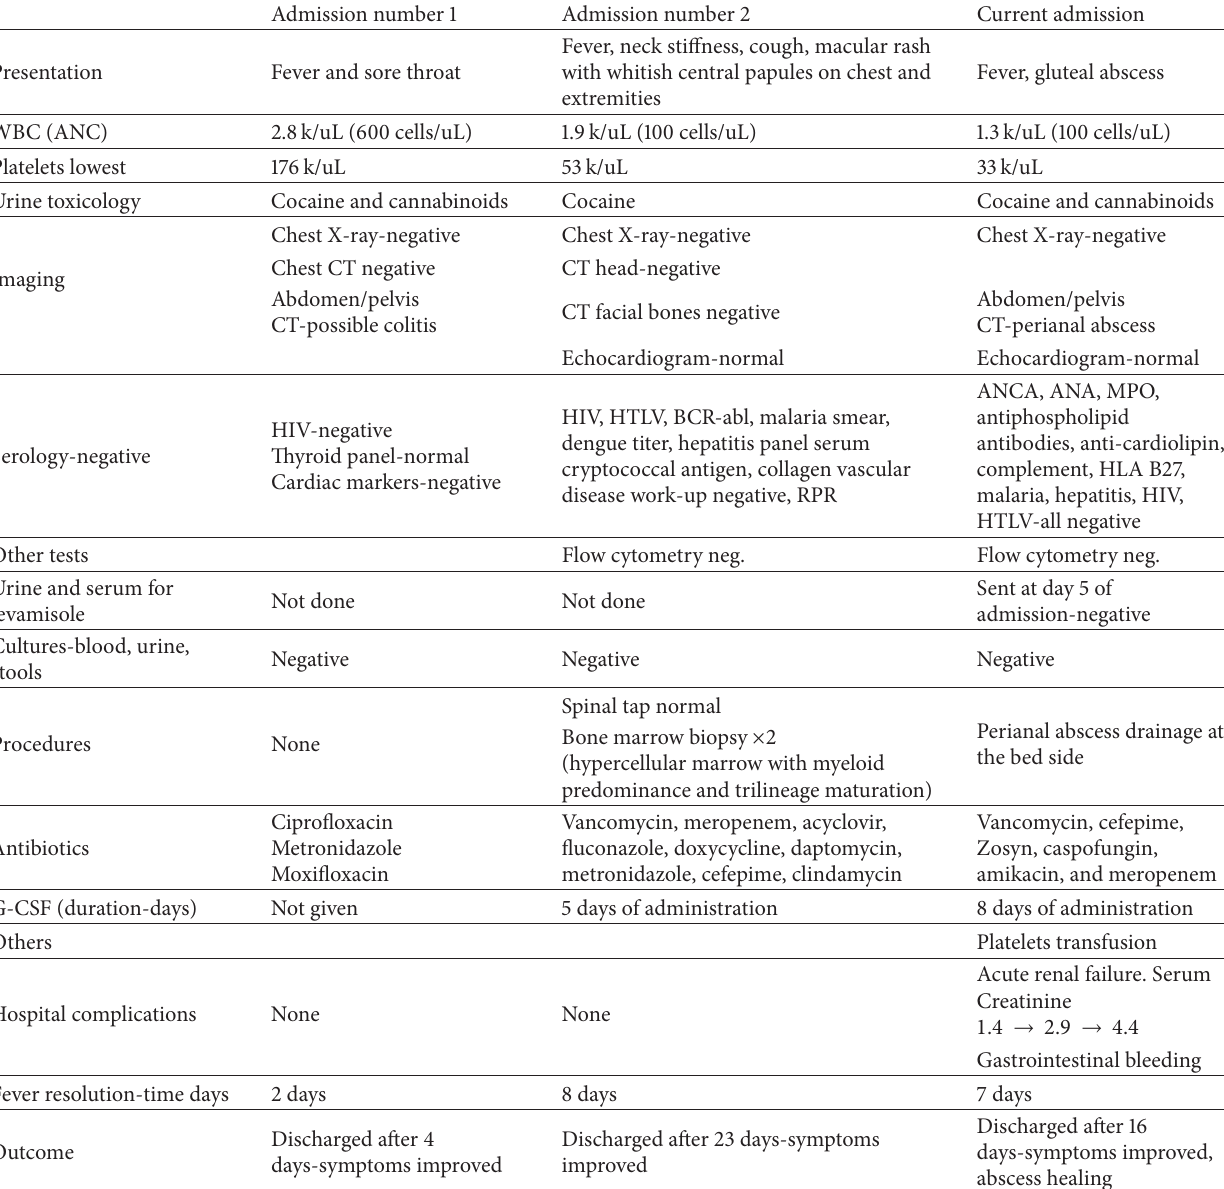
Table 1: Comparison of characteristics during the three